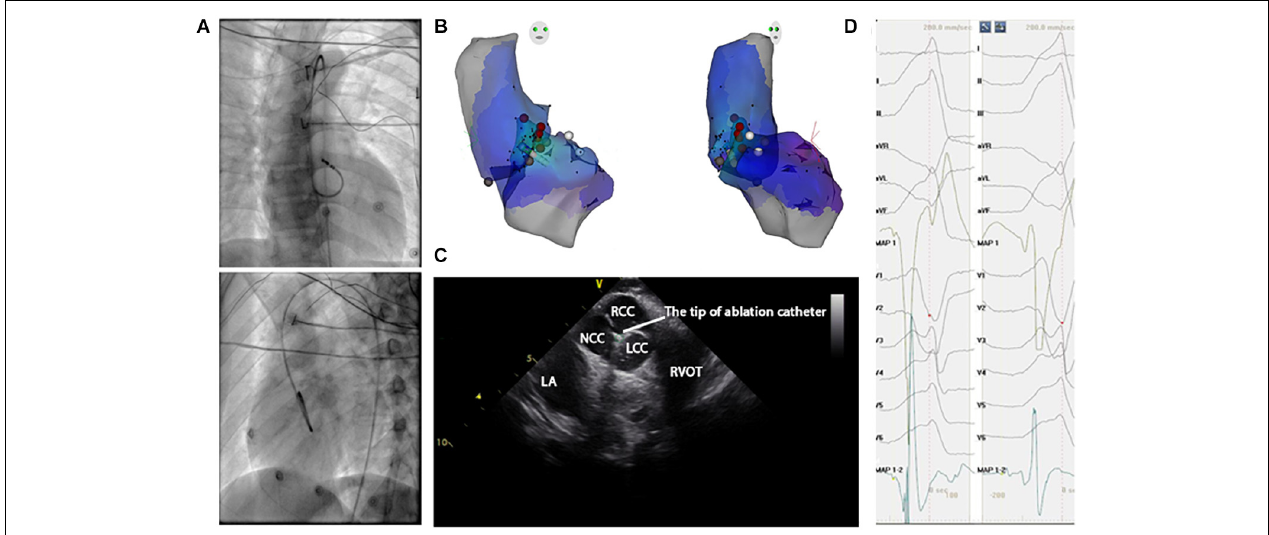
FIGURE 3 | Activation map and fluoroscopic map for VA originating from commissure of aortic sinus of valsalva in LVOT. (A) Right and left anterior oblique fluoroscopic views show an ablation catheter in the LVOT. Ablation in the LVOT (LCC–RCC commissure) eliminated the PVC within 3 s. (B) The 3-D anatomic representation of the RV endocardium, LV endocardium, and venous system with the ablation catheter positioned at the anterior interventricular vein. (C) The green circle indicates the tip of the ablation catheter in LCC–RCC commisure. (D) The earliest bipolar and unipolar activation time (–30 ms) are